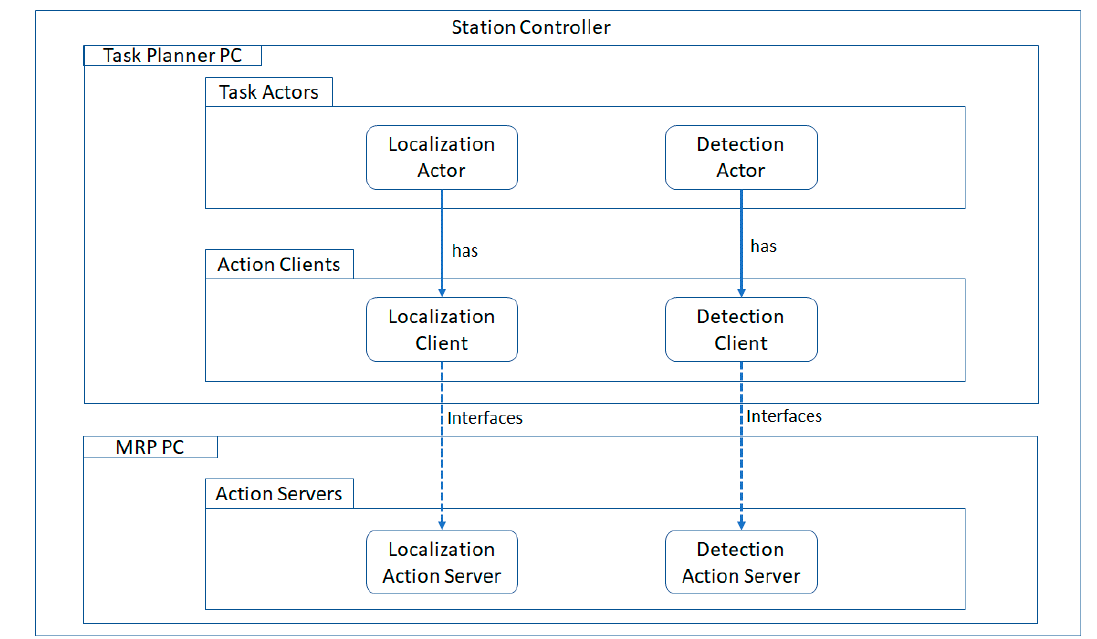
Figure 10. Station controller .